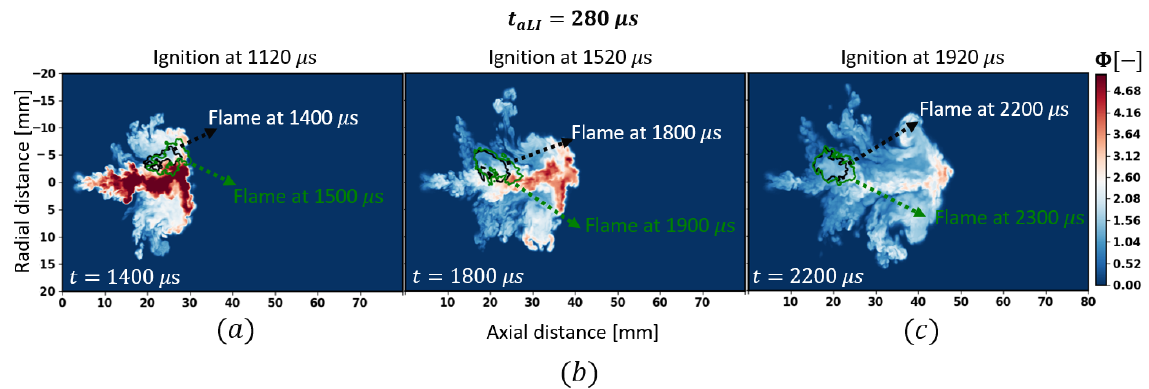
Figure 13. Slices of equivalence ratio at 280 µ s after laser ignition. The back and the green lines represent respectively the flame boundary at 280 and 380 µ s after laser ignition. The flame boundary is defined by c = 0.5.